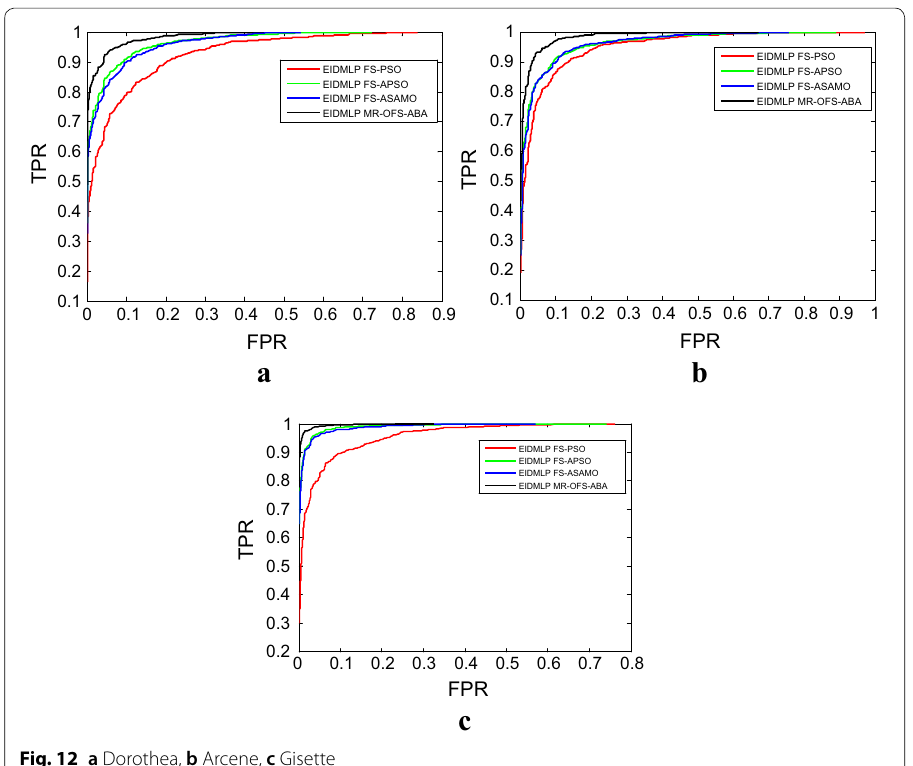
Fig. 12 a Dorothea, b Arcene, c